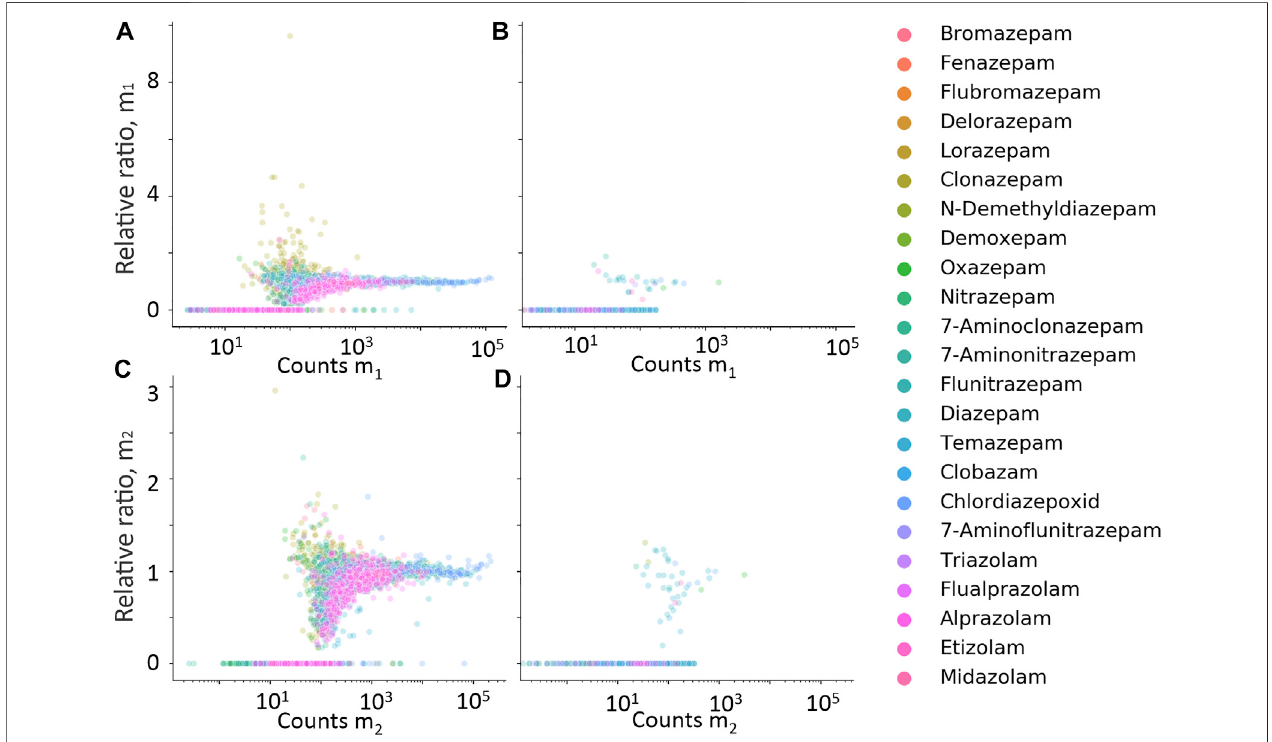
FIGURE 5 | Relative ratio between expected isotope ion counts, and measured isotope ion counts for m 1 (A,B) and m 2 (C,D) plotted against measured counts of m 1 and m 2 , respectively. Data in (A,C) are hits from cases with positive quantitative results, and (B,D) from cases with negative quantitative results.